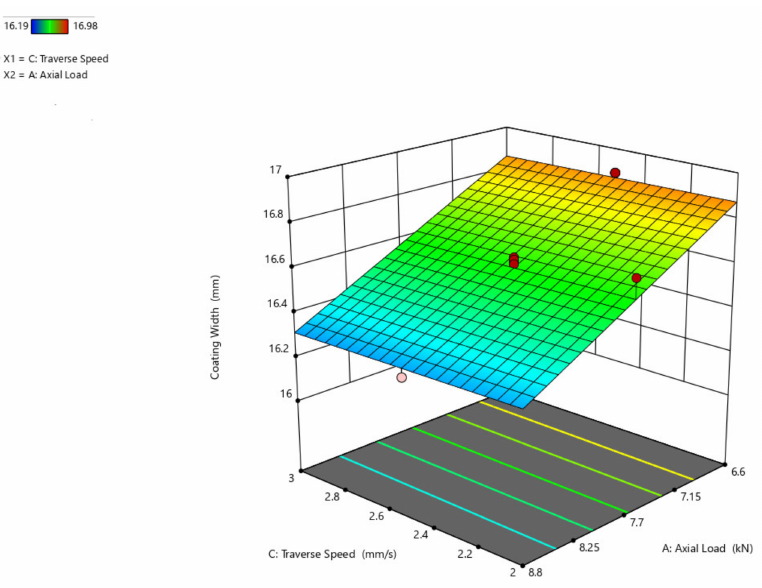
Figure 9. Interaction plot of axial load and traverse speed on coating width (C w ).